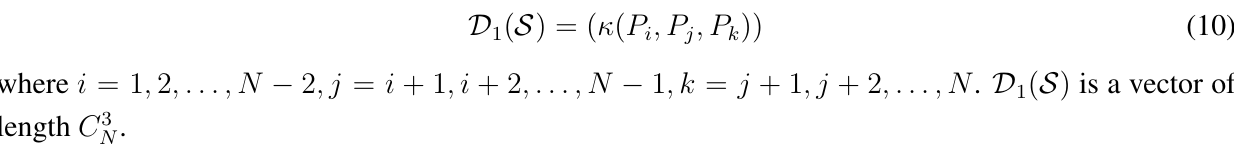
Figure 5. Points to calculate the characteristic number when ( a ) r = 2 and ( b ) r = 3